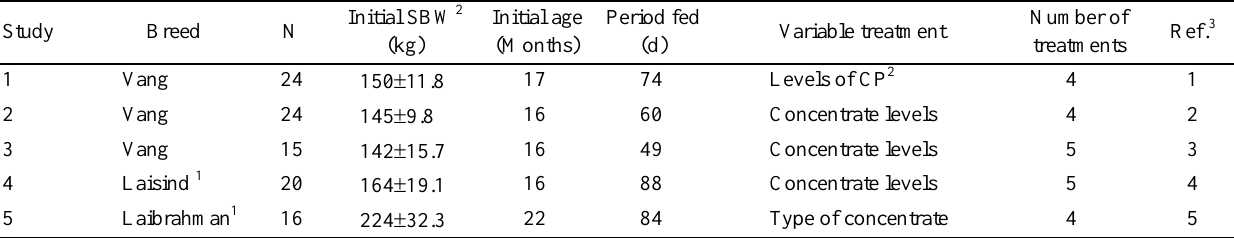
Table 1. Summary of studies used for evaluating the large ruminant nutrition system for Vietnamese Yellow (Vang) purebred and crossbred cattle fed under Vietnamese